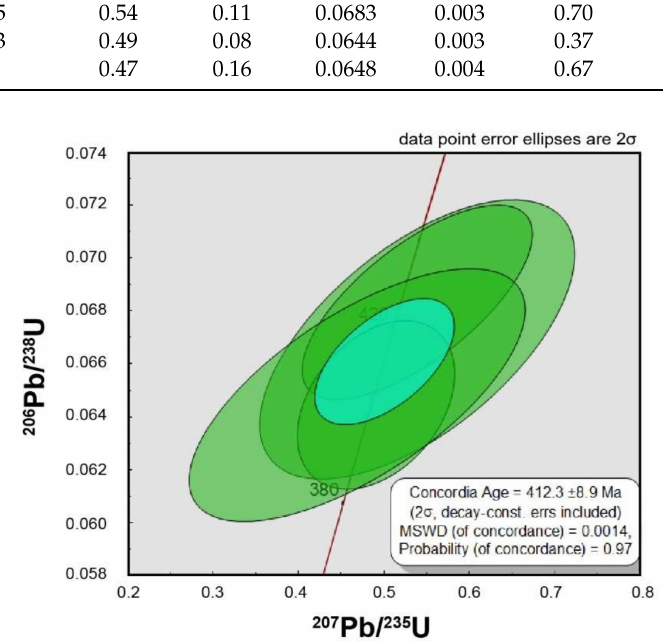
Figure 17. U-Pb concordia diagram displaying the youngest 204 Pb corrected concordant 206 Pb- 238 U date produced using titanite from a lamprophyre dyke. The date listed above is a 204 Pb corrected concordant 206 Pb- 238 U date (data shown in Table